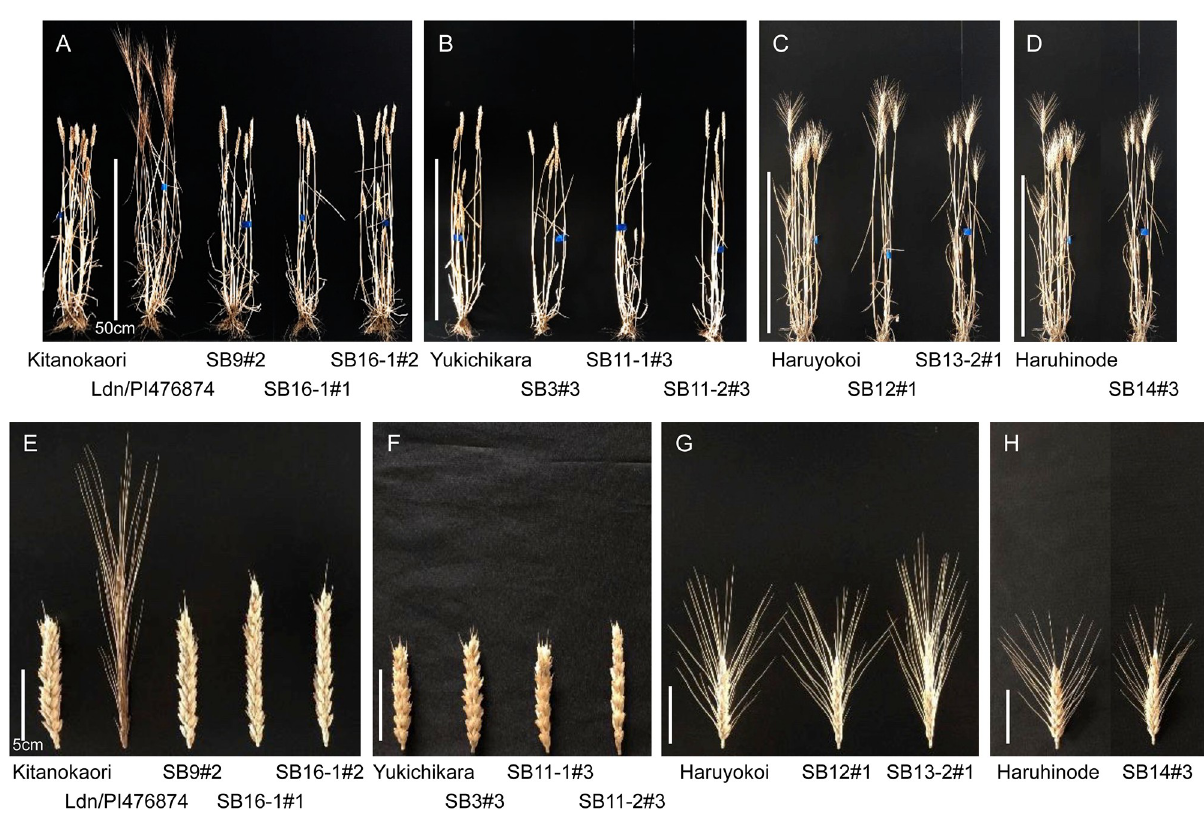
Fig 1. Photos of plant appearances and spikes in the selected early heading lines and their parental wheat cultivars.